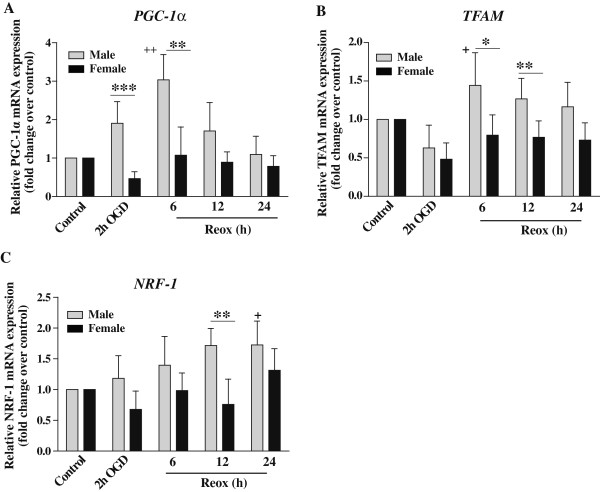
Effects of OGD (2 h) followed by Reox (6–24 h) on transcription factors involved in mitochondrial biogenesis in XY and XX CGNs. A) PGC-1α, (B) TFAM and (C) NRF-1 mRNA expression was determined by RT-qPCR at indicated times as described in materials and methods. The PGC-1α, NRF-1 and TFAM mRNA expression (normalized to HPRT) were upregulated in XY as compared to XX CGNs during OGD/Reox. Results are mean ± SD (n = 4, *p < 0.05, **p < 0.01, ***p < 0.001, XX vs. XY, +p < 0.05, ++p < 0.01 vs. control, a one-way ANOVA followed by Bonferroni/Dunn post hoc test was applied).